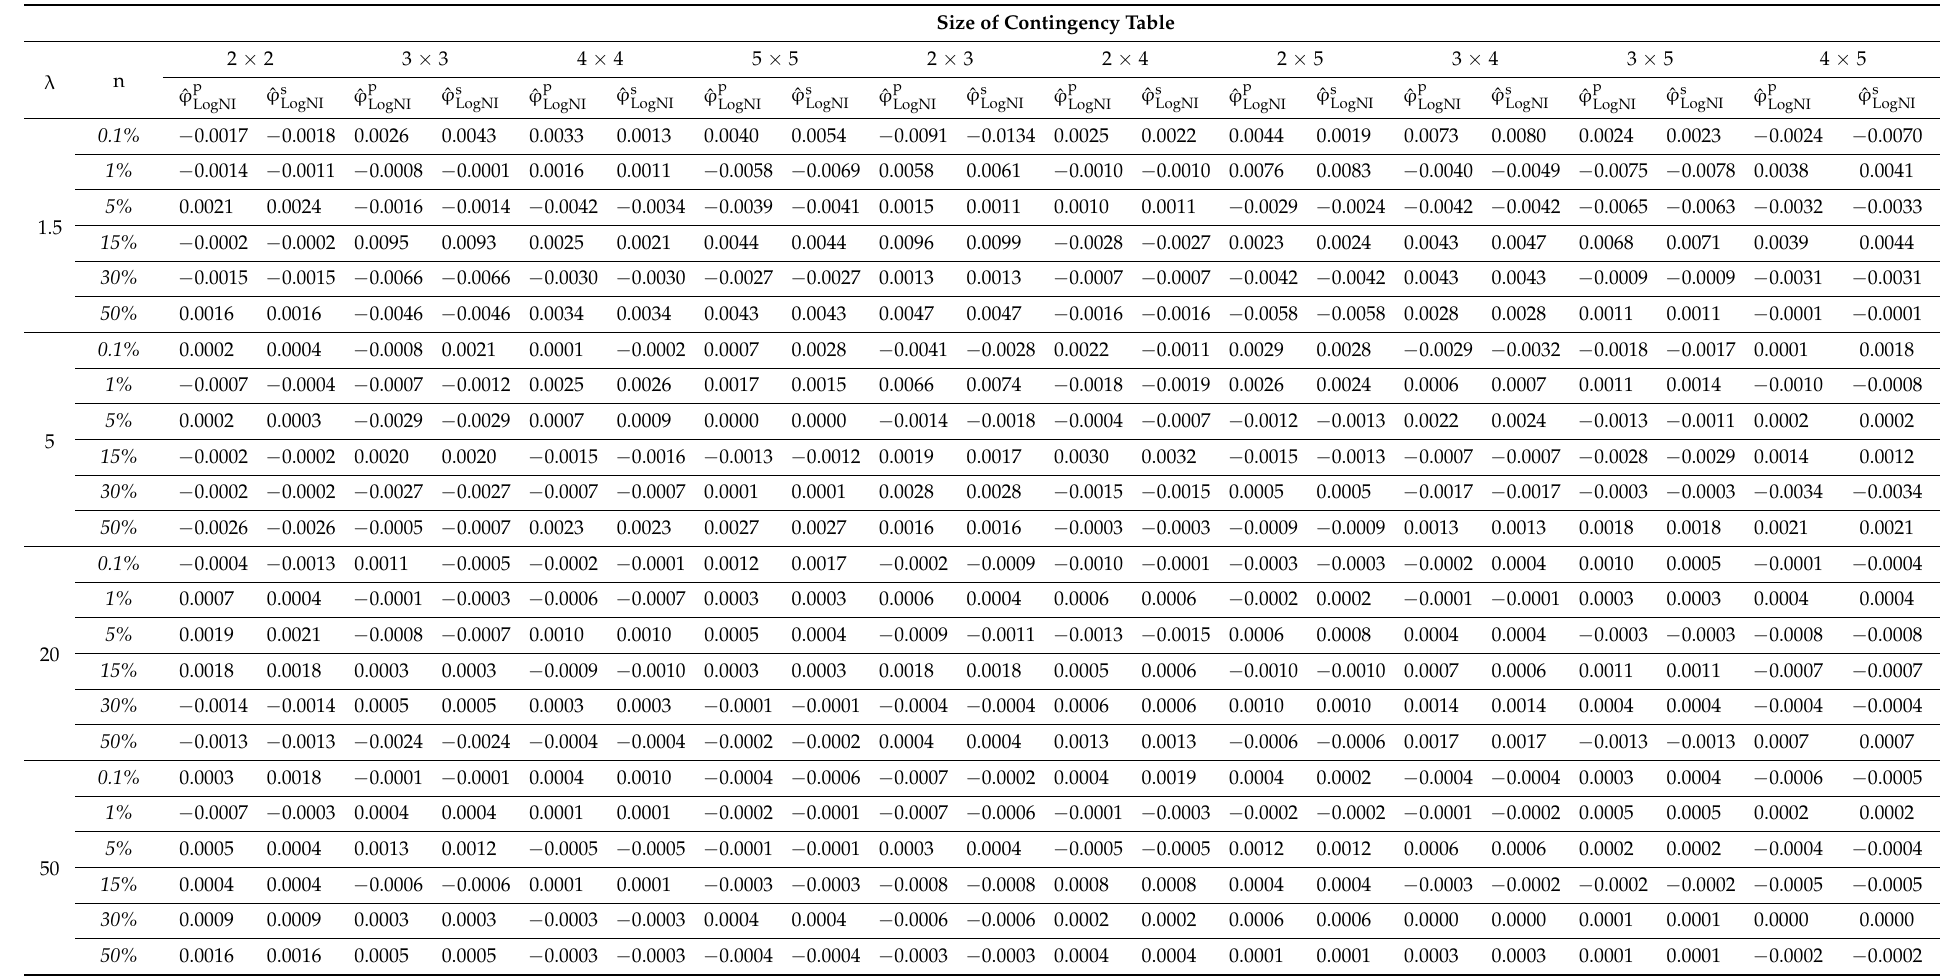
Table 1. Property of unbiasedness of ˆ ϕ LogNI for varying dimensions, sample sizes, and λ s of simulated contingency